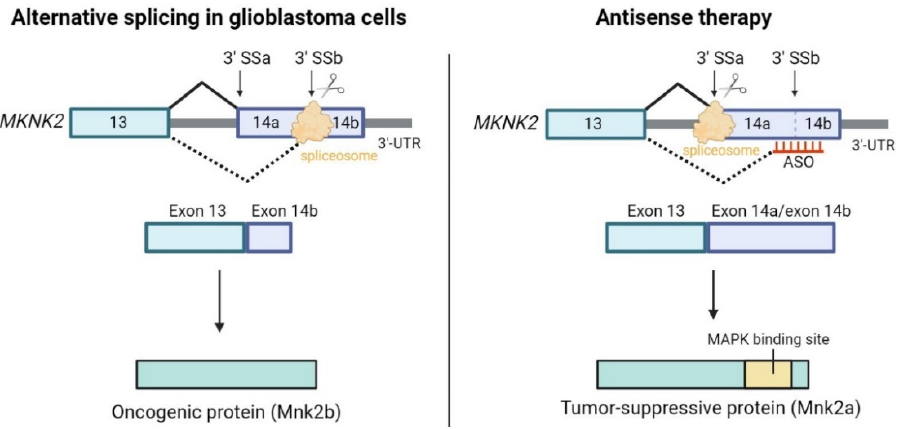
Figure 2. Therapeutic strategy using antisense oligonucleotides. MKNK2 encodes the kinase Mnk2, and exon 14 is defined by two different alternative 3 ′ splice sites (3 ′ SSa and 3 ′ SSb). In glioblastoma cells, the spliceosome binds to the 3 ′ SSb splice site, producing the oncogenic isoform Mnk2b. Using an ASO to block this site favors the use of 3 ′ SSa, and the tumor-suppressive protein Mnk2a is produced [223].